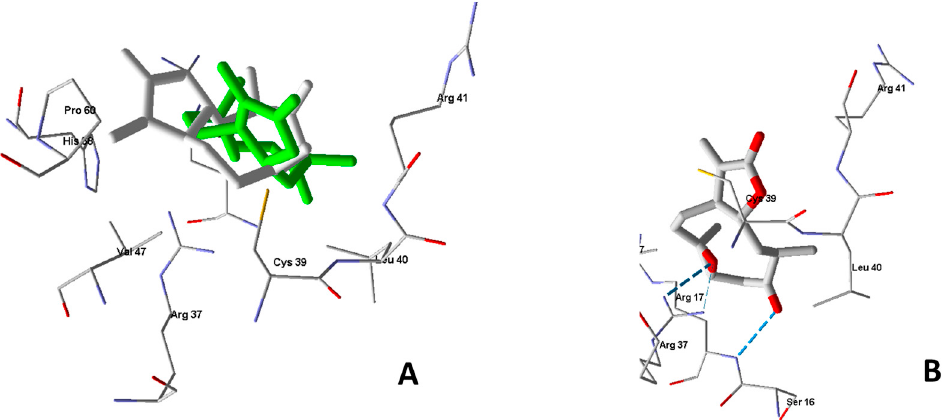
Figure 5. Docking poses of argolide ( 2 ) and 1 β ,10 α -epoxyargolide ( 2a ) and in the ZAP-70 SH2 module. Panel ( A ) is the docking poses of 1 β ,10 α -epoxyargolide ( 2a ) (green) and argolide ( 2 ) (grey). Residues within 7 Å of the center of the search space are shown. Panel ( B ) is the docking pose of 1 β ,10 α -epoxyargolide ( 2a ). Residues within 3 Å of the pose are shown. H-bonds are shown as blue dashes.